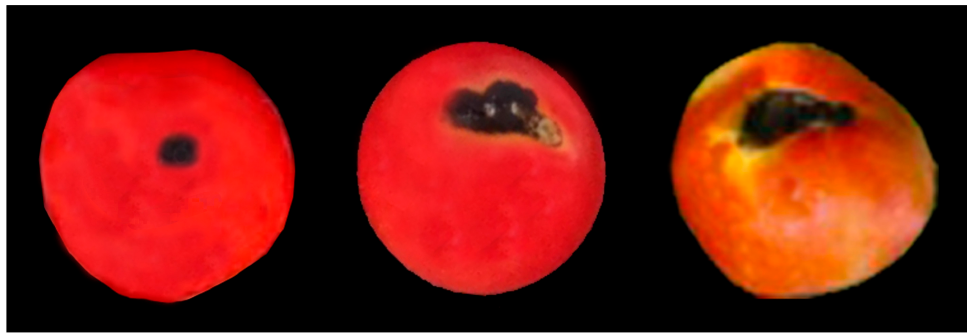
Figure 1. Symptoms of tomato anthracnose observed in the tomato gardens in Sabah,